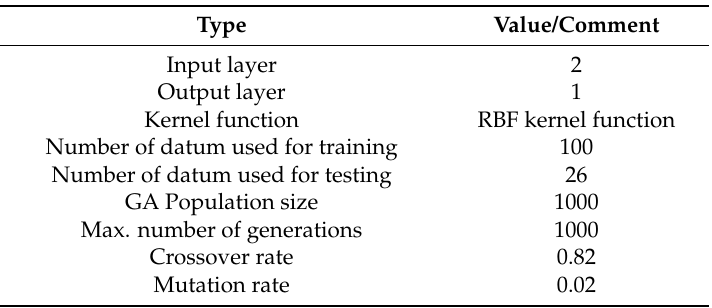
Table 2. Basic parameter values of GA-LSSVM model for the prediction of viscosity and thermal conductivity of Fe 2 O 3 /ethylene glycol-water